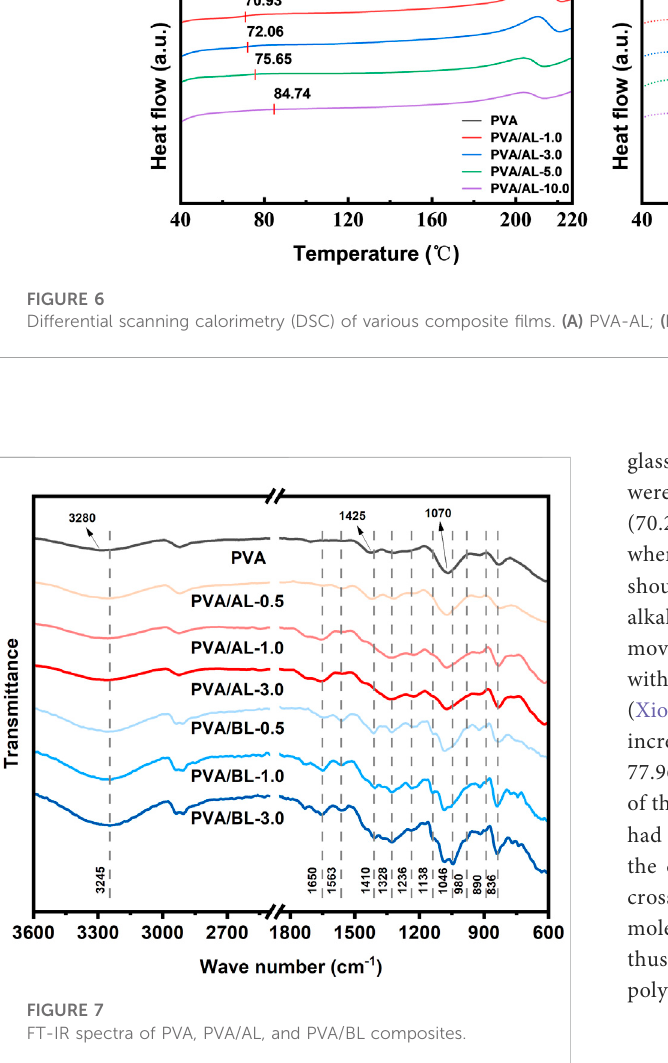
Frontiers in Bioengineering and